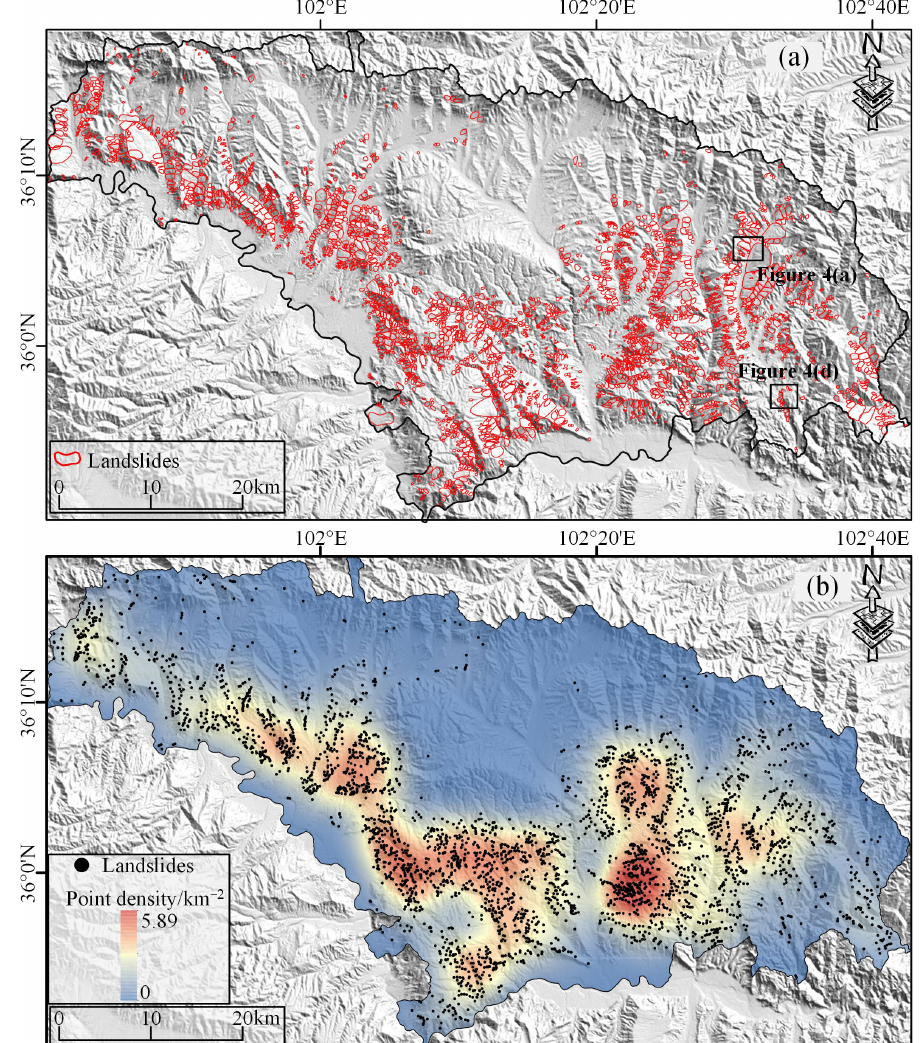
Figure 3. ( a ) Landslide distribution map and ( b ) density